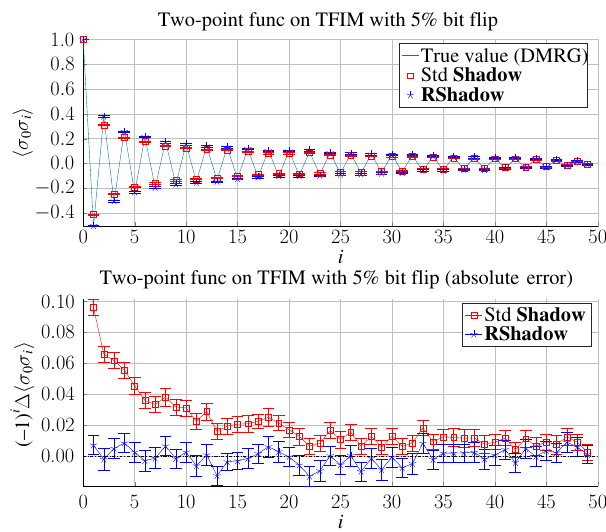
FIG. 4. Two-point correlation function estimation on a 50-spin one-dimensional (1D) TFIM ground state.